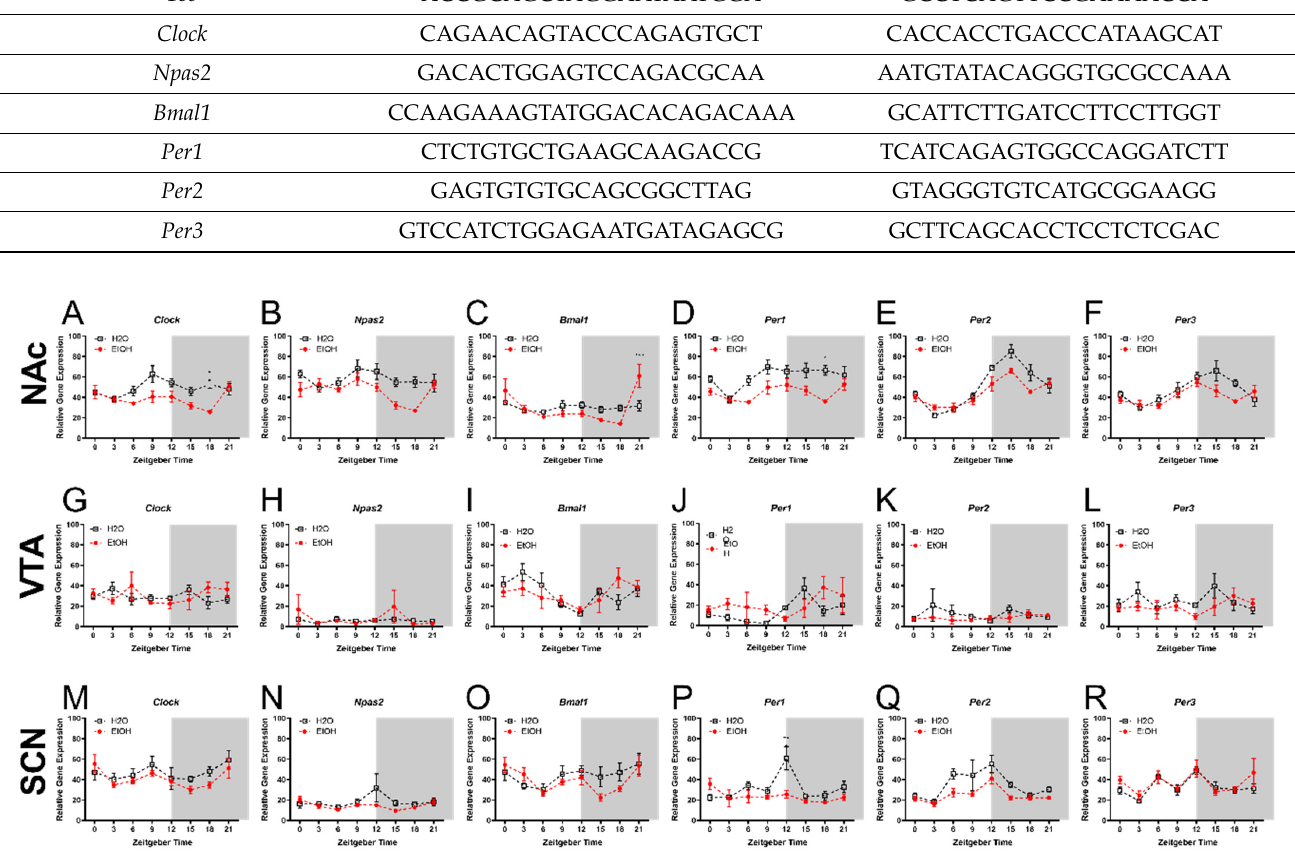
Table 1. Chronic binge-like ethanol drinking reduces expression of circadian genes in the NAc and SCN of female HDID-1 mice in Experiment 1. Descriptive statistics for the NAc, VTA, and SCN. Descriptive Statistics for Experiment 1